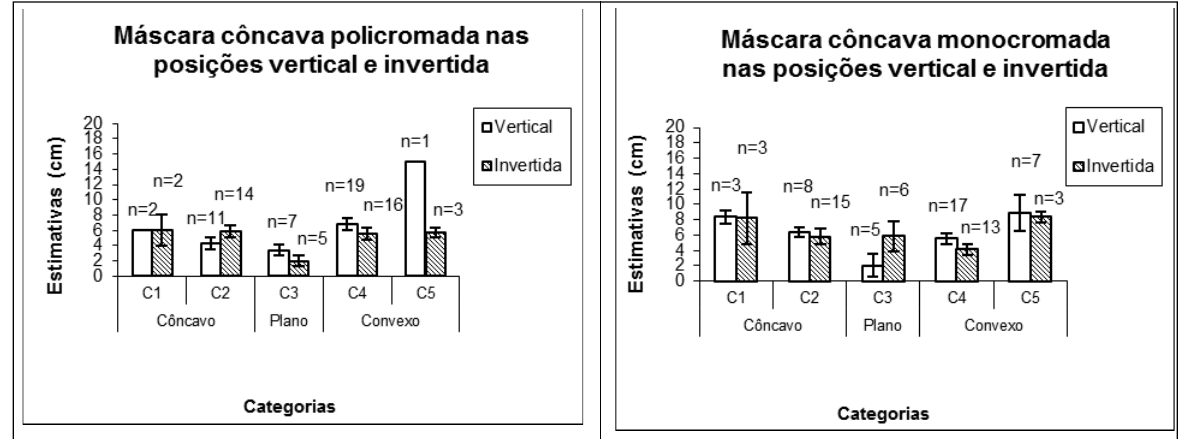
Figura 3 . Estimativas médias e erros padrão da profundidade ou relevo percebido entre o nariz e a base da face das máscaras cônca- vas policromada e monocromada na posição vertical iluminada por cima da cabeça e na posição invertida iluminada por baixo para as categorias: plenamente côncavo (C1), moderadamente côncavo (C2), plano (C3), moderadamente convexo (C4) e plenamente convexo (C5), por 40 participantes. n = frequência de respostas por